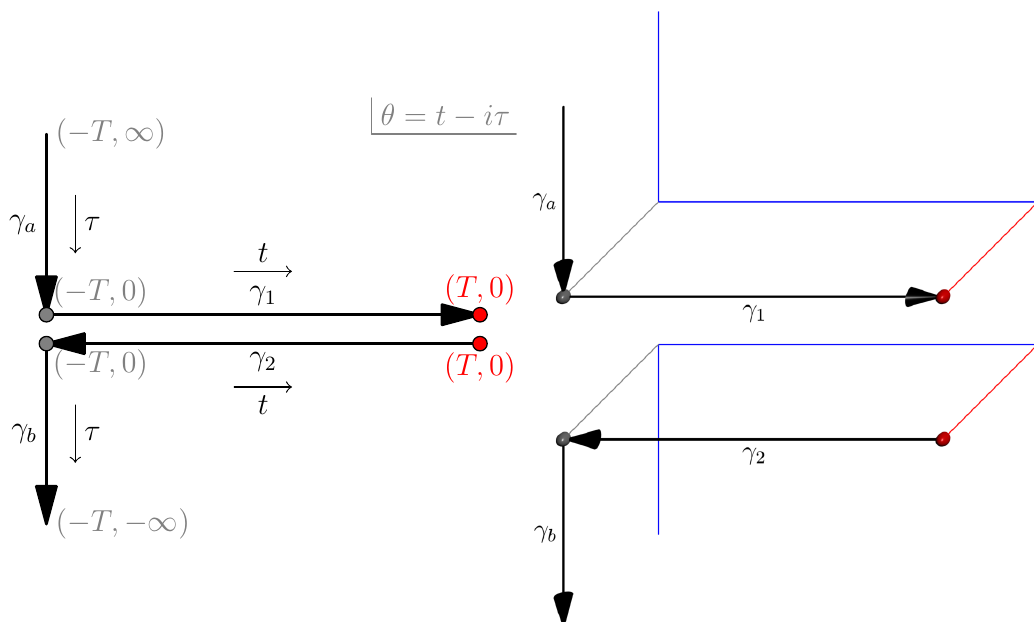
Figure 5. The pure-state Schwinger-Keldysh contour in CFT 2 (left) and the mixed-signature bulk spacetime, corresponding to it (right). On the boundary contour (left) the grey dots signify gluing between an Euclidean and a Lorentzian segment and the red dots are identified and also glued. On the bulk contour (right) the fields are glued on a fixed time slices extending all the way into the bulk. The blue line is the suface r ∗ = 0 . On this mixed-signature diagram we have included only the right side of the wormhole, but the reader should envision that the left side is glued to the blue line as in figure